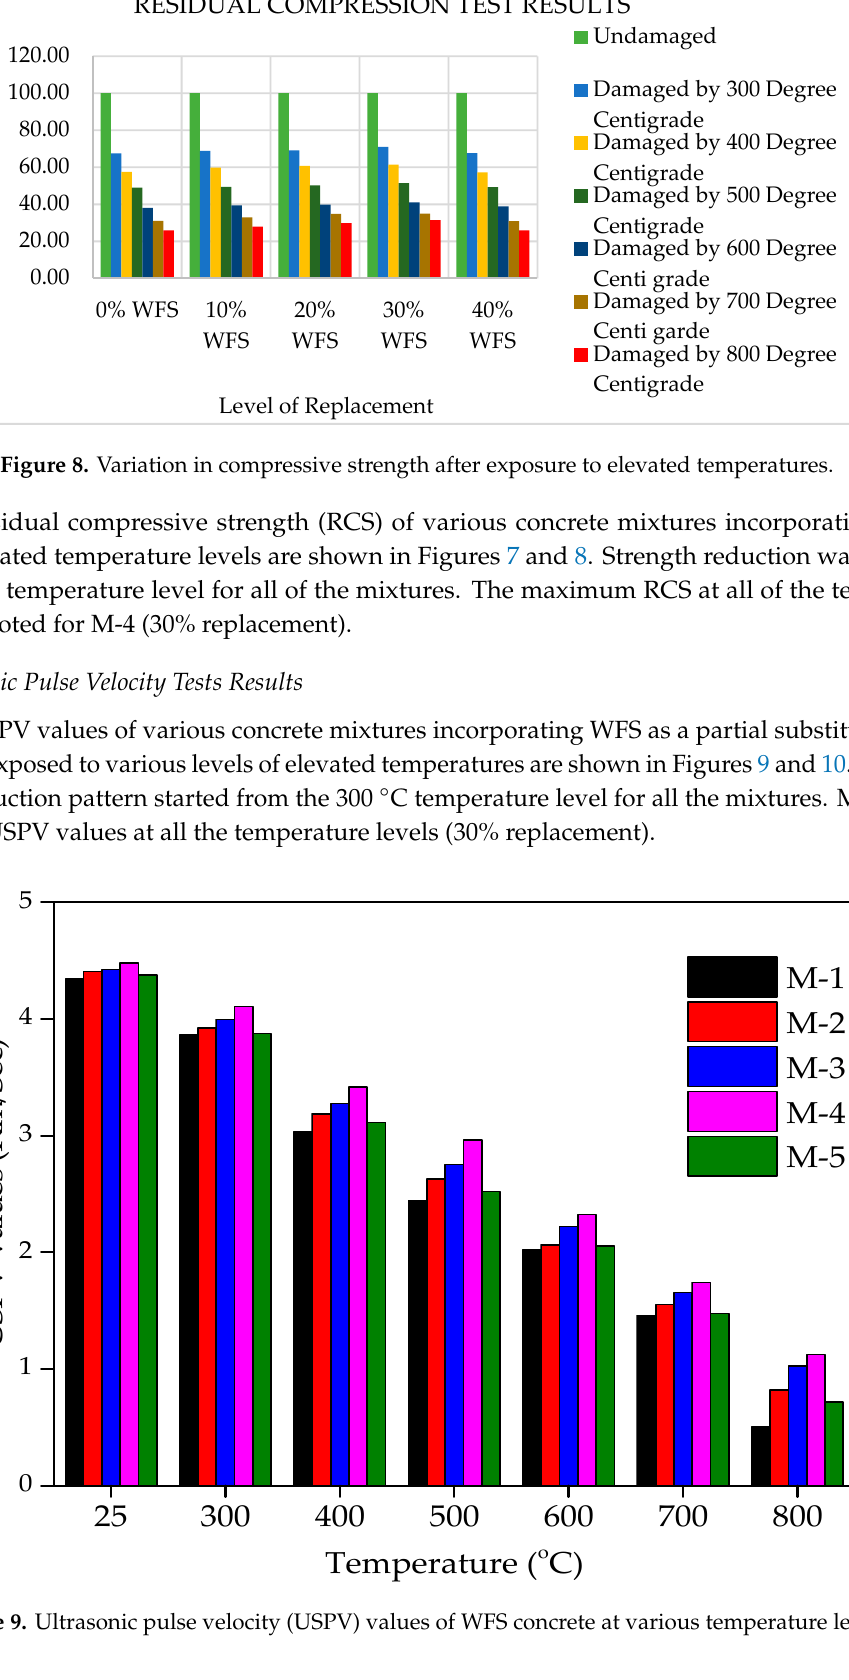
Figure 7. Residual compressive strength (RCS) of WFS concrete at various temperature levels.